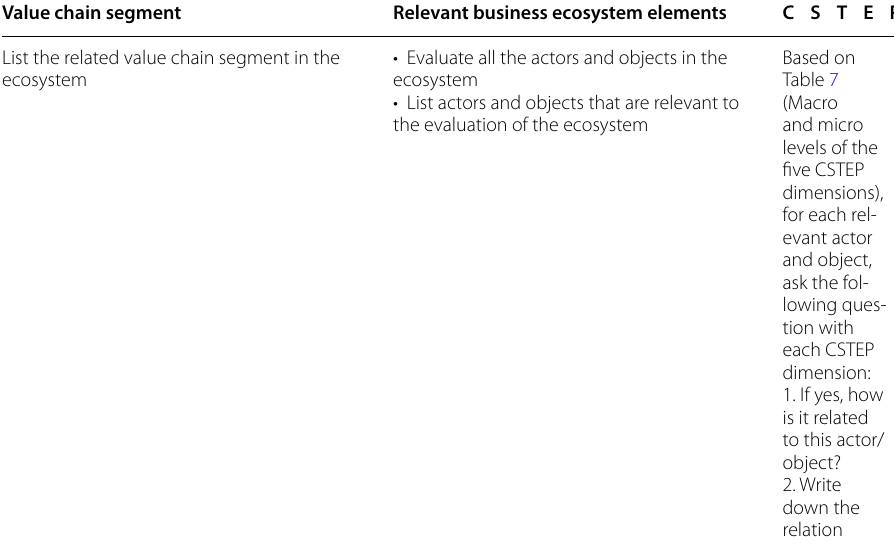
Regarding the business ecosystem architecture development, please see (Ma et al. 2021) for details